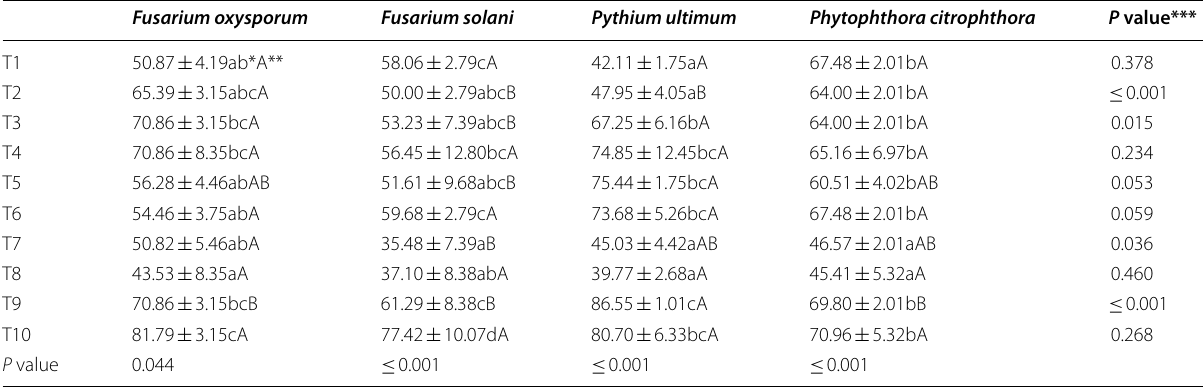
*Means standard error in the column followed by the same lowercase letter are not significantly different according to SNK test at P ± **Means standard error in a row followed by the same capital letter are not significantly different according to SNK test at P ±